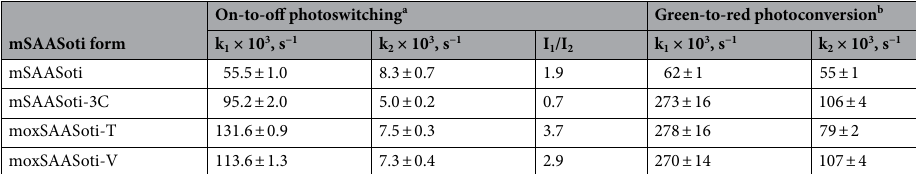
On-to-off photoswitching